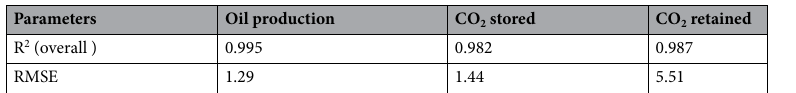
Table 2. The correlation factor and Root Mean Square Error for data-driven ANN